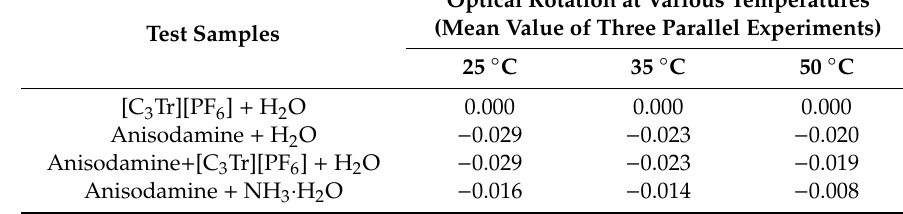
Table 5. Values of optical rotation of four samples at di ff erent temperatures after mixing for 30 min under 90 W ultrasonic